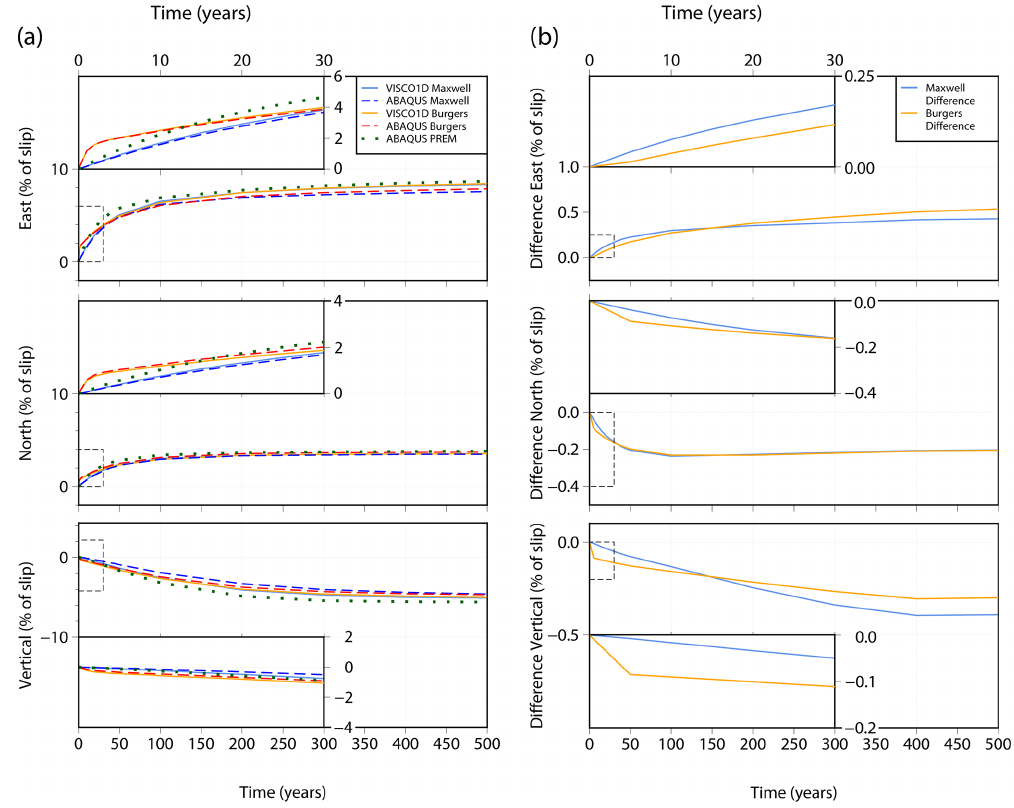
Figure 6. (a) Post-seismic surface displacement through time in the east, north and vertical directions at a location 100km perpendicular to the fault in Fig. 5. Predictions using two rheologies are shown: Maxwell rheology using VISCO1D and Abaqus ; and Burgers rheology using VISCO1D and Abaqus (see legend). Predictions from Abaqus using the PREM elastic properties are also shown (green dots). The main plot for each displacement direction shows 500 years of displacement with the first 30 years shown in detail in the insets. Displacements are given as a percentage of the fault slip. (b) Difference between the Abaqus post-seismic displacement and the VISCO1D displacement for Maxwell rheology (light blue line) and Burgers rheology (orange line). Positive indicates Abaqus has less displacement than VISCO1D and negative indicates Abaqus has more displacement than VISCO1D . Differences are in terms of percentage of the fault slip. Note different scales on the y